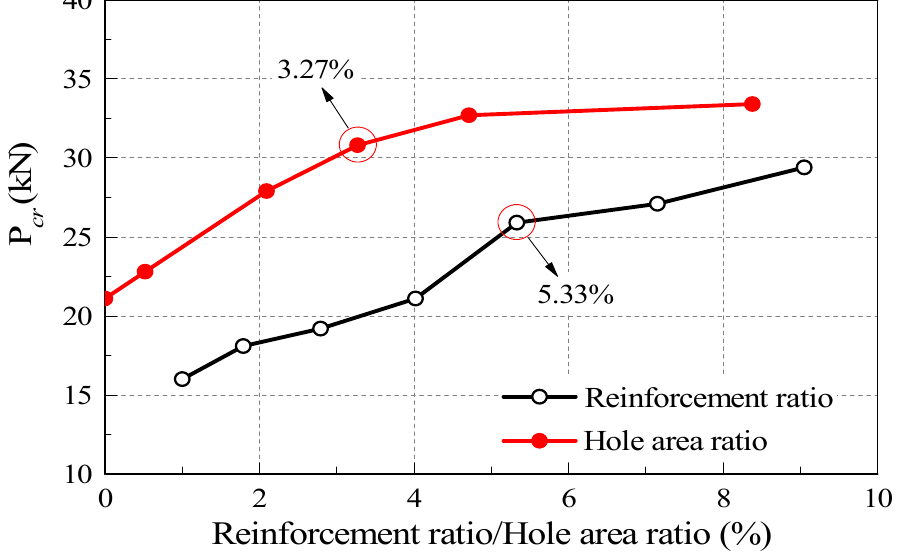
Figure 11. Load of first crack at interface versus reinforcement ratio and mortise hole area ratio.